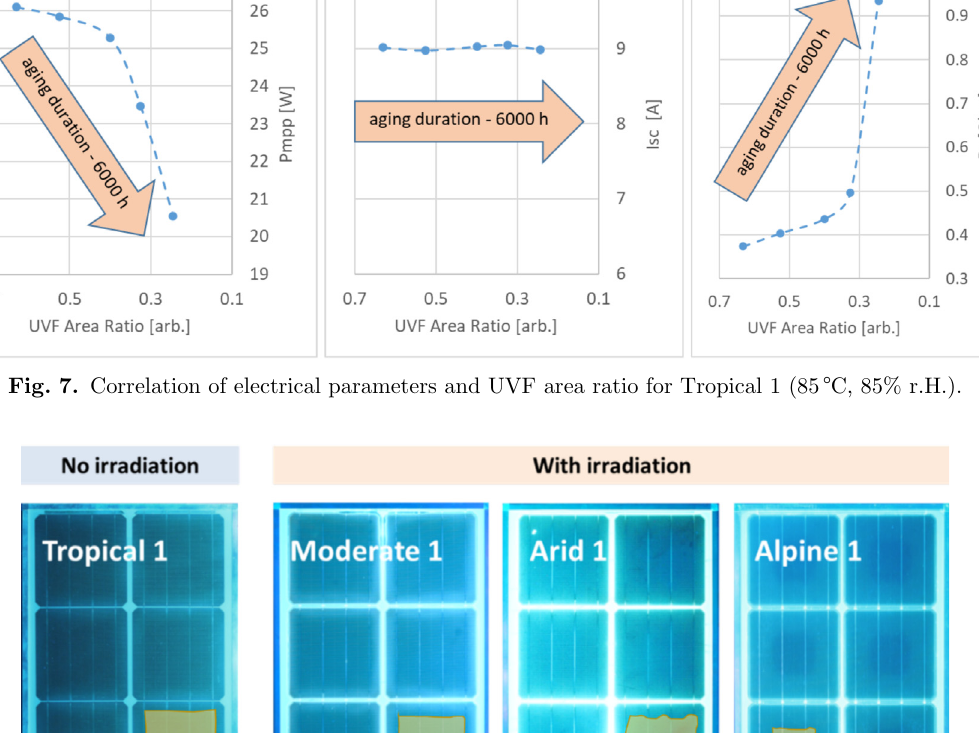
(Tropical1)storageisgiveninFigure11.Itisobviousthatthe